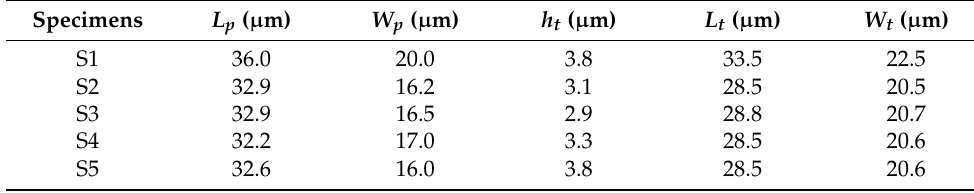
Table 2. Dimensions of the push-out specimens.